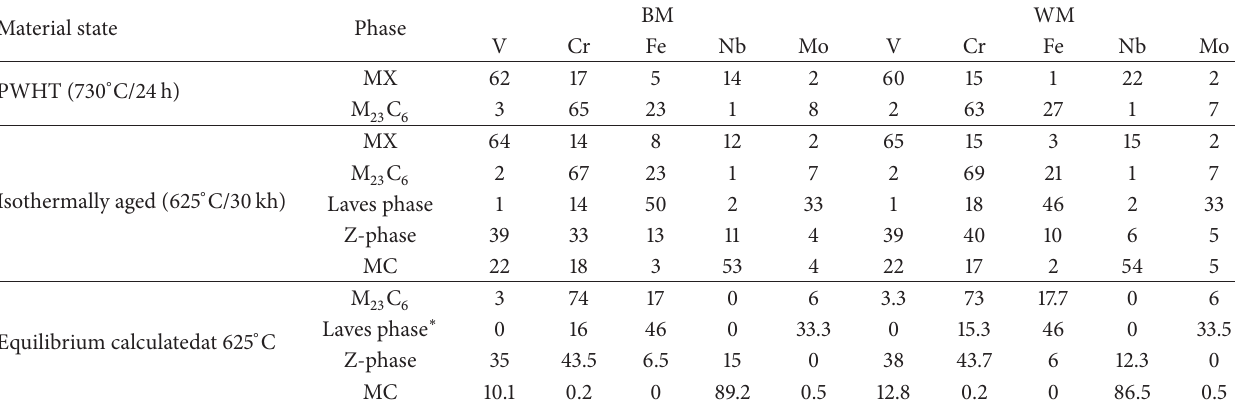
Figure 3: SEM-micrographs of thermally exposed microstructures at 625 ∘ C for 10 kh of BM (a, b) and WM (c, d) of the CB2 weldment visualized using secondary electrons (a, c) and back-scattered electrons (b, d). Table 2: Mean chemical composition (metallic part) in at.% of precipitate phases in CB2 weld regions and material states and calculated equilibrium phase composition at 625 ∘